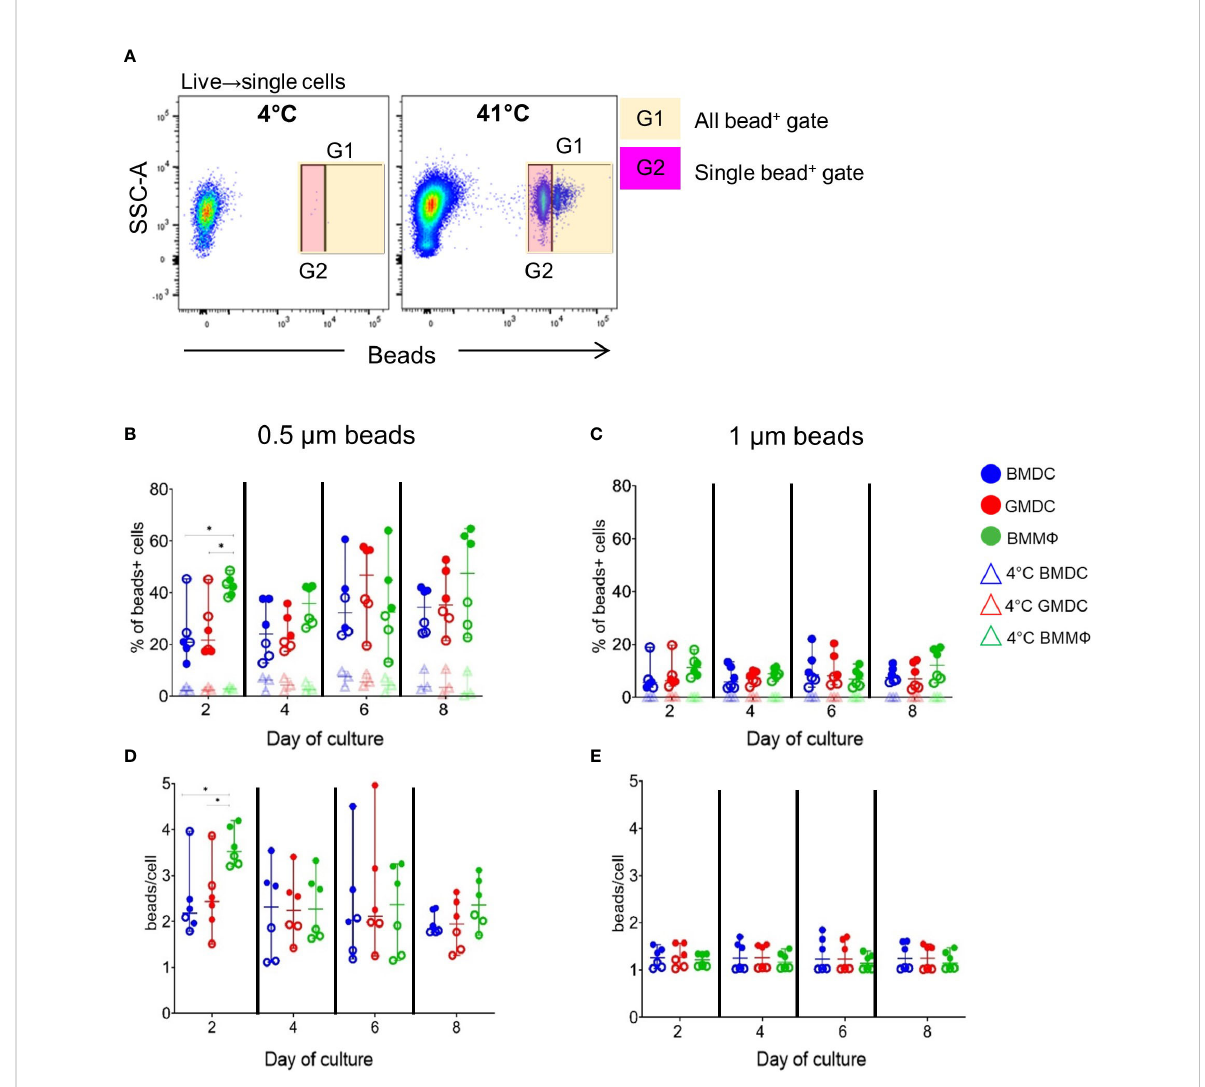
FIGURE 4 Endocytic activity of BMDC, GMDC and BMM F cultures. BMDC (blue), GMDC (red) and BMM F (green) were incubated with 0.5 µm or 1 µm fl uorescent beads at 41°C (circles) or 4°C (triangles) for 2 h on days 2, 4, 6 and 8 of culture and phagocytosis was analyzed by fl ow cytometry. (A) Representative fl ow plots of the gating strategy to determine speci fi c bead uptake using the cells treated at 4°C and applied to the cells treated at 41°C. An all bead+ gate (G1) and a gate for cells with a single bead (G2) were applied. (B) The percentage of 0.5 µm bead + cells; (C) and 1 µm bead + cells; (D) the number of 0.5 µm beads per cell; (E) the number of 1 µm beads per cell; The number of beads per cell was calculated by dividing MFI of cells in G1 by cells in G2. Data represents the median (± range). From each bird (n=6), BMDC, GMDC and BMM F were generated. Data represents two independent experiments (n=3 per experiment, open & closed circles). Signi fi cant differences are indicated by *p